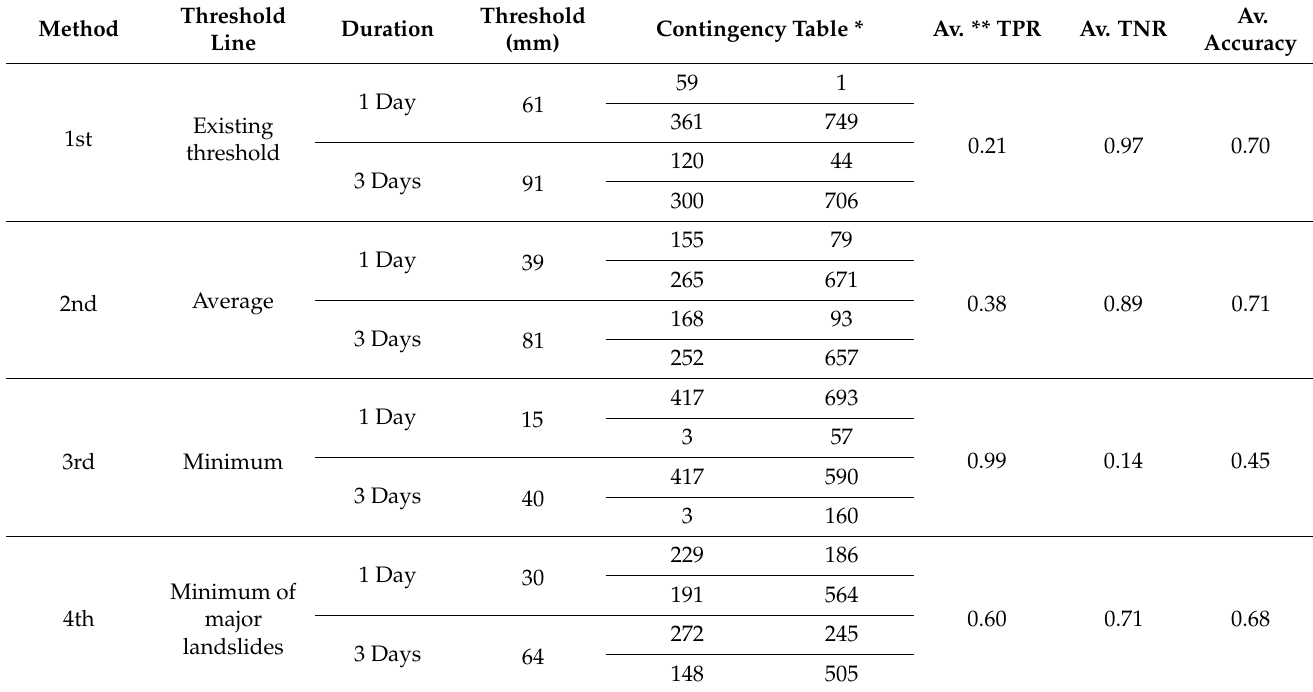
Table 4. Result of the confusion matrix and statistical indices.